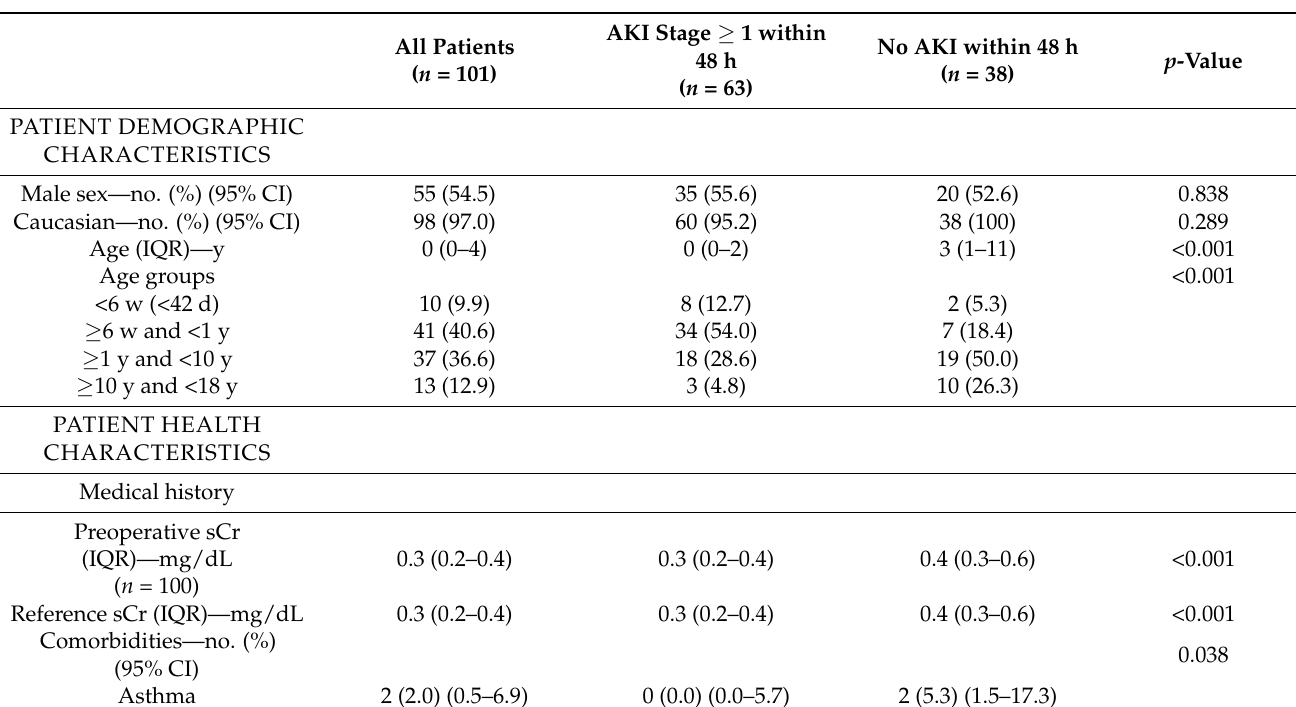
Table 1. Characteristics of the pediatric patients, the cardiac surgery procedures, and